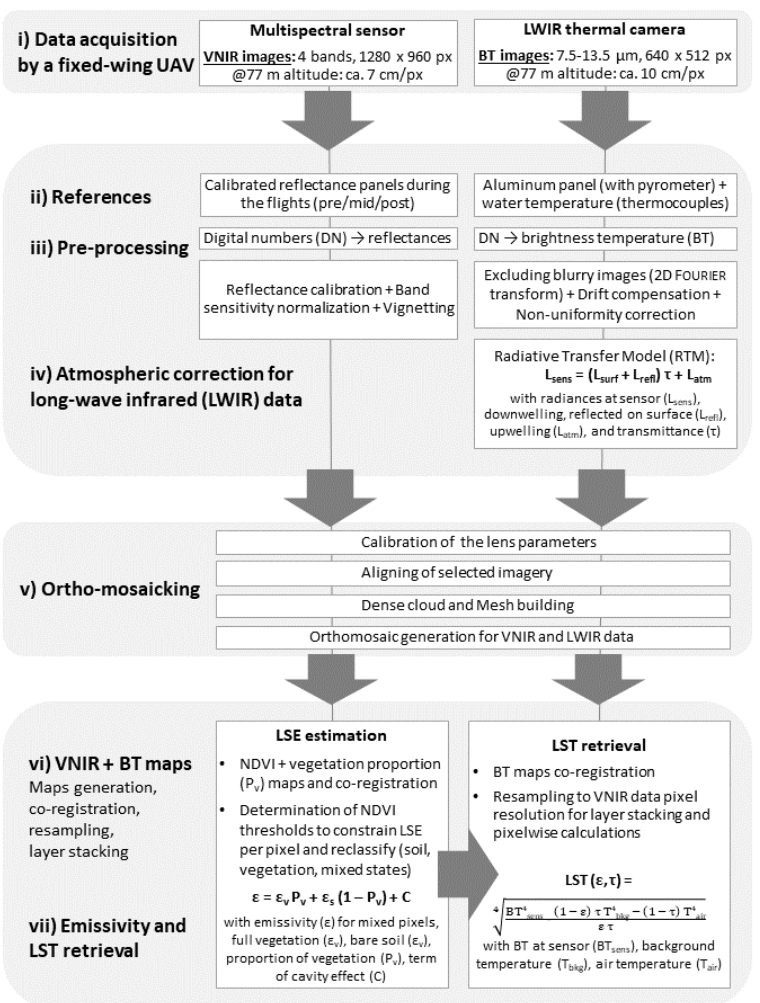
Figure 1. Flowchart of the proposed Unmanned Aerial Vehicle (UAV)-based method to retrieve precise Land Surface Temperature (LST): ( i ) Visible and near infrared (VNIR) and long-wave infrared (LWIR) data acquisition; ( ii ) Reference measurements for VNIR and LWIR data during the flights; ( iii ) Preprocessing of the acquired data; ( iv ) Atmospheric correction for the thermal domain; ( v ) Ortho-mosaic generation; ( vi ) Co-registration, resampling and layer stacking of the VNIR and brightness temperature (BT) maps; ( vii ) Computation of the Land Surface Emissivity (LSE) and LST